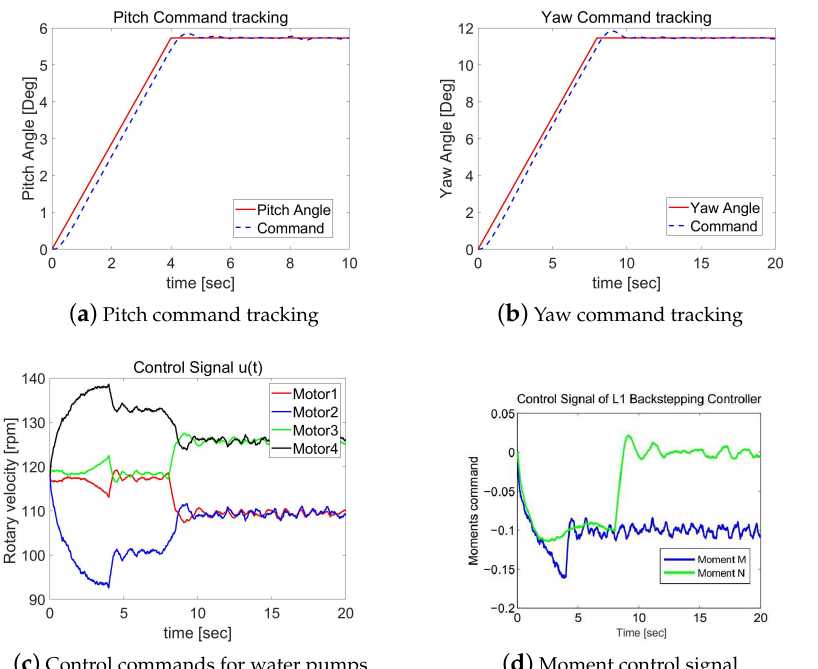
Figure 5. Case 1: Simulation results of the L 1 backstepping